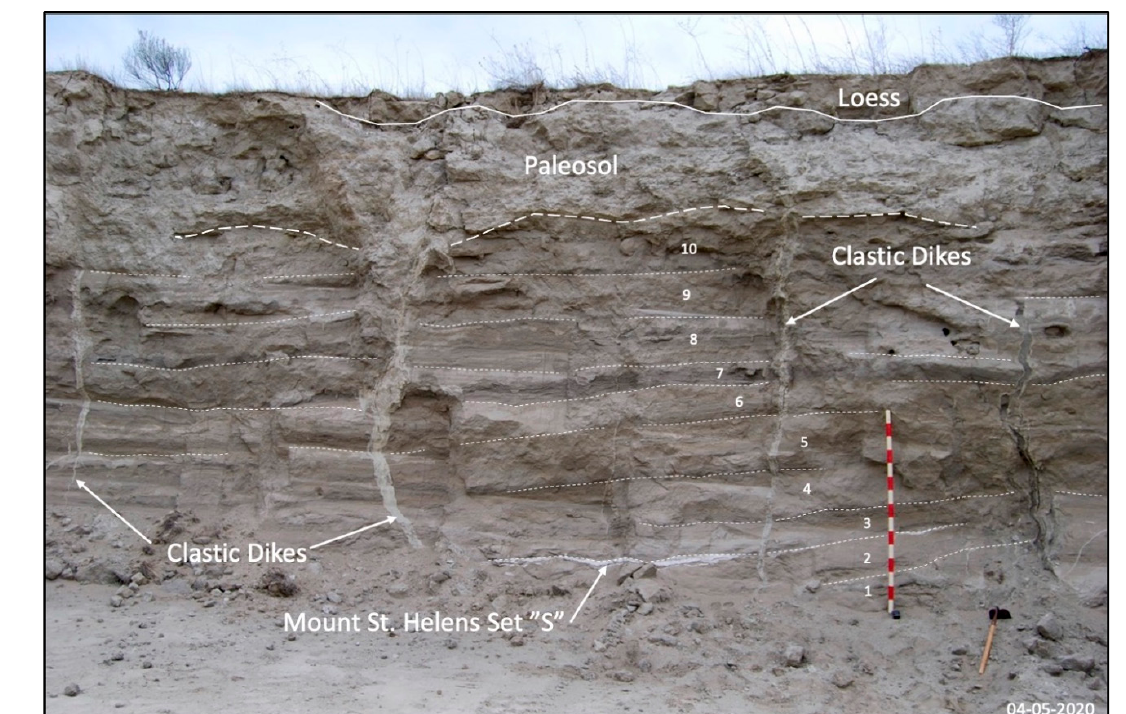
Figure 9. Graph of OSL and radiocarbon ages from the Coyote Canyon area (in yellow) compared with other available ages for Missoula flood deposits (rhythmites and erratics) from the main body of Lake Lewis (within the Pasco Basin), relative to their elevations.